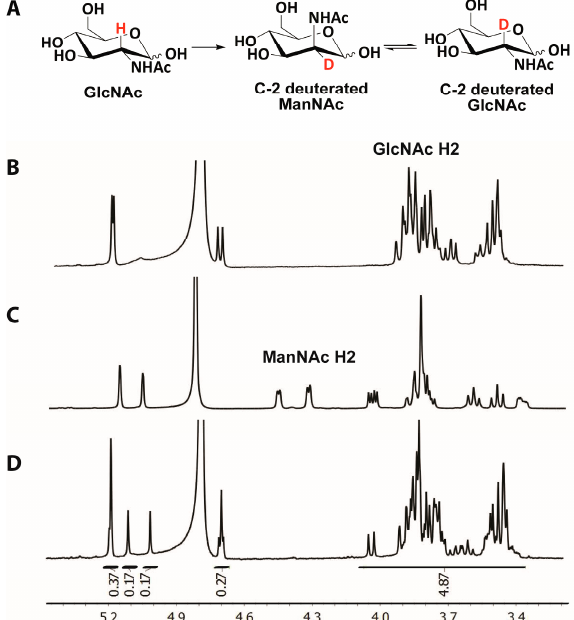
Figure 4. ( A ) : Reaction scheme of PhGn2E ‐ catalyzed deuterium substitution at the C ‐ 2 position of Figure 4. ( A ): Reaction scheme of PhGn2E-catalyzed deuterium substitution at the C-2 position of GlcNAc allowing the formation C-2 deuterated ManNAc; ( B ): 1 H-NMR spectrum of GlcNAc in D 2